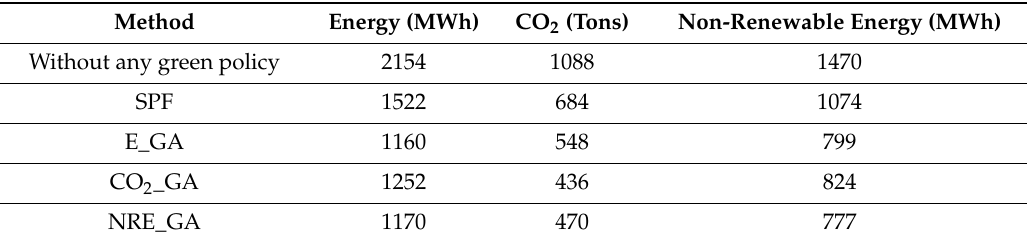
Table 3. Energy, cost and CO 2 emission analysis for a year.